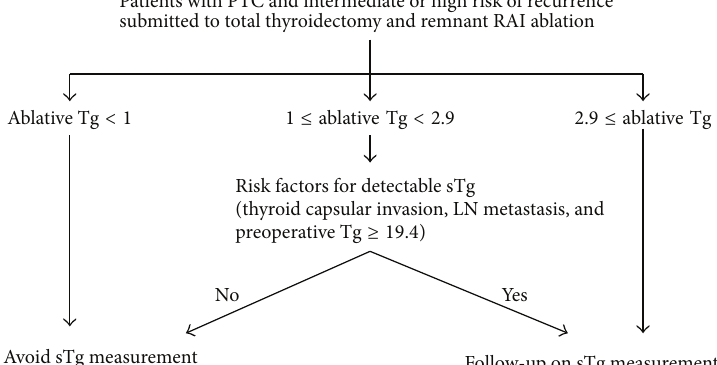
Figure 1: An algorithm for determining whether to measure sTg in thyroid cancer patients at intermediate to high risk of recurrence at 6–12 months after radioactive remnant